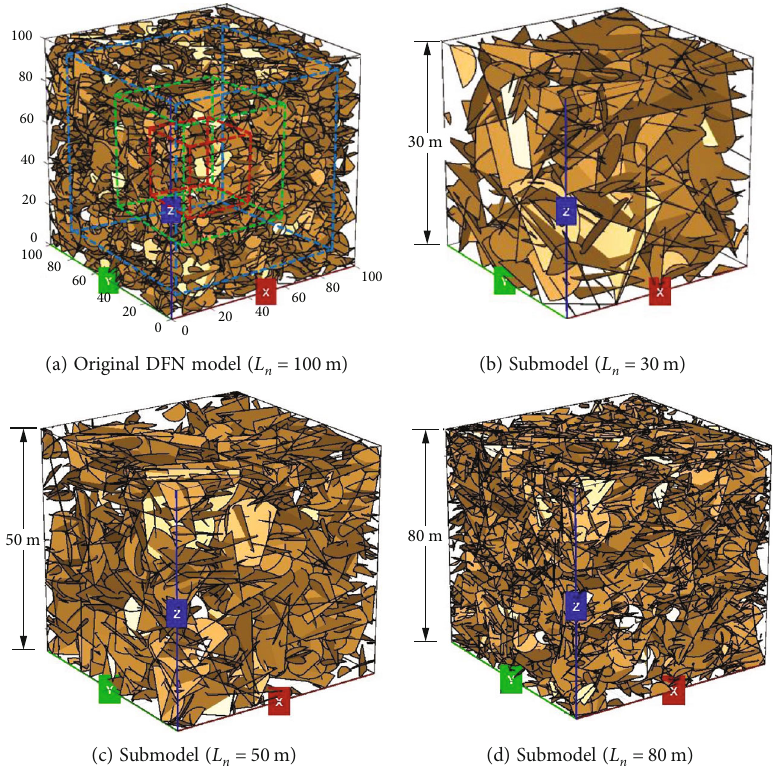
Figure 9: Examples of extracting submodels from the original DFN model.